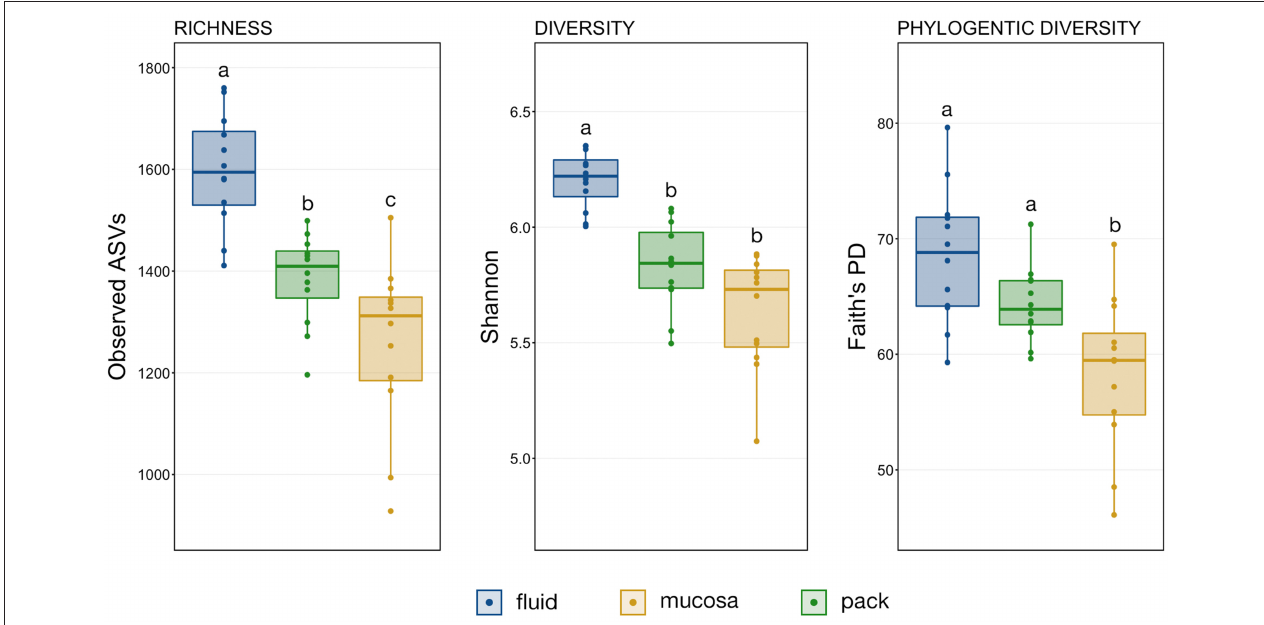
FIGURE 1 | Boxplots displaying the number of observed ASVs and Faith’s Phylogenetic Distance for each ruminal component (fluid, pack, mucosa). Significant differences in richness and diversity between components are illustrated by different letters (Pairwise Wilcoxon rank-sum with Benjamini-Hochberg correction, p < 0.05, n =